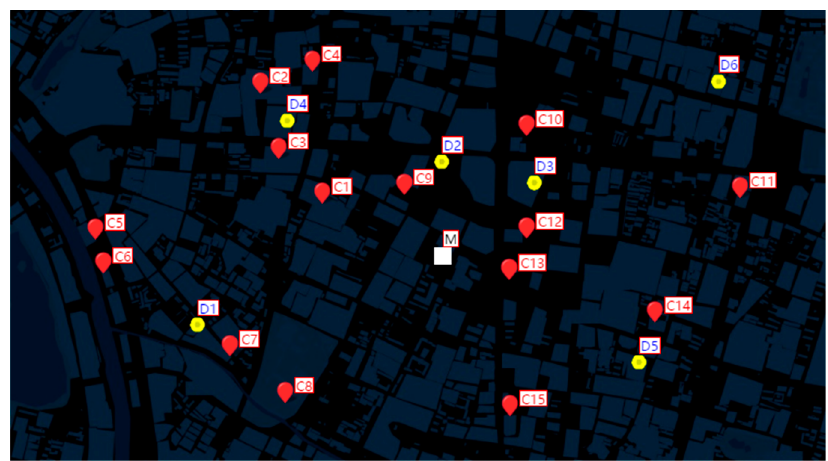
Figure 3. Spatial distribution of vehicle visiting points (Map resource: Baidu).